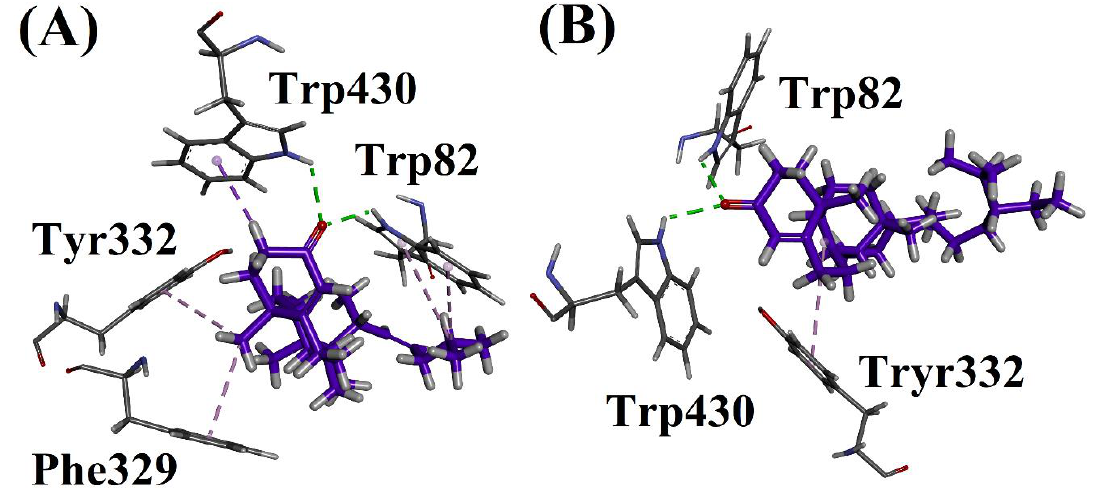
Figure 3. ( A ) Interactions of compound 1 and ( B ) Interactions of compound 2 in active site of 4BDS.